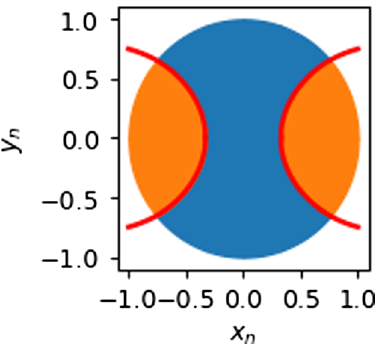
FIG. 22. Initial conditions in the unit disk in the x are divided into two geometric regions by the curves I ¼ 2 H (red curves).